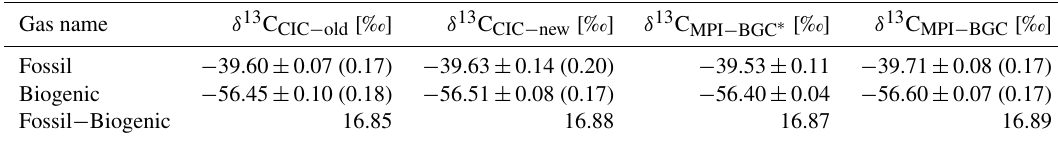
Table 4. Results for comparison in δ 13 C between CIC and MPI-BGC. Indices of the header are explained in Sect. 2.9 of the main text. The CIC data are corrected for the offset in RM 8563 (Coplen et al., 2006b) and scale compression effects. They are furthermore presented with revised uncertainties to include the full traceability chain (Sect. 2.4). The uncertainties of the full traceability chains with the recently sug- gested uncertainty in LSVEC of 0.15‰ are shown in brackets. The δ 13 C MPI − BGC ∗ measurements used a system that is virtually unaffected by scale compression (Ghosh et al., 2005) and a WS calibration that is based on NBS 19 as the only CRM; therefore, the δ 13 C MPI − BGC ∗ data do not suffer from the uncertainty in LSVEC. The difference Fossil − Biogenic can be used to compare scale compression effects between the respective